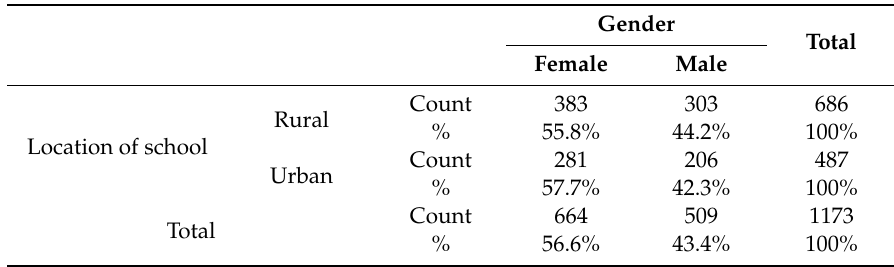
Table 2. Gender and locations for